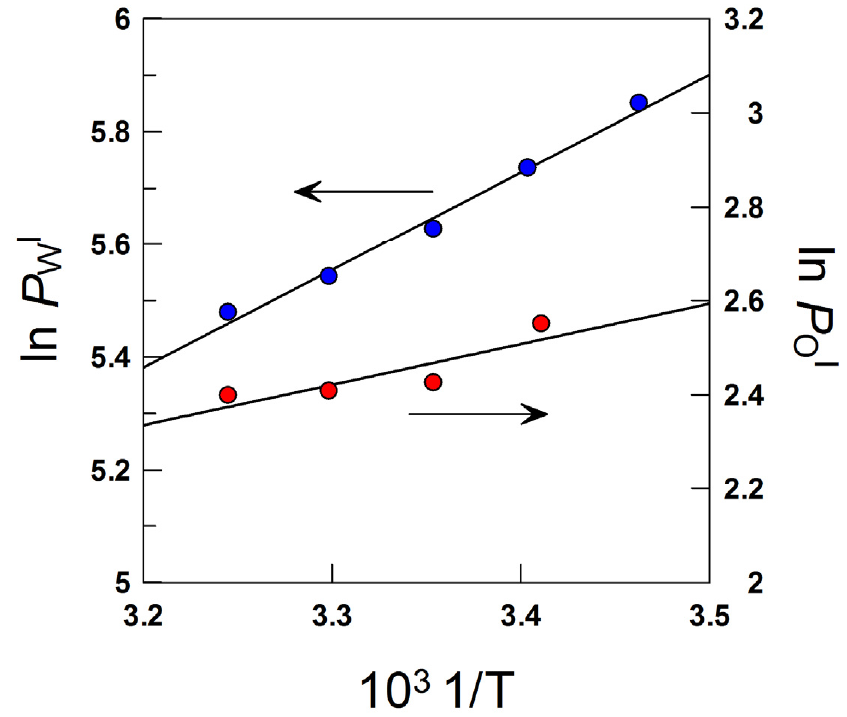
Figure 13. Variations of ln P OI and ln P WI with 1/ T (Kelvin) according to the van’t Hoff equation for caffeic acid (blue) and α -tocopherol (red) in corn oil emulsions. Figure reproduced from Losada- Barreiro et al. [90] with permission, copyright Royal Society of Chemistry.